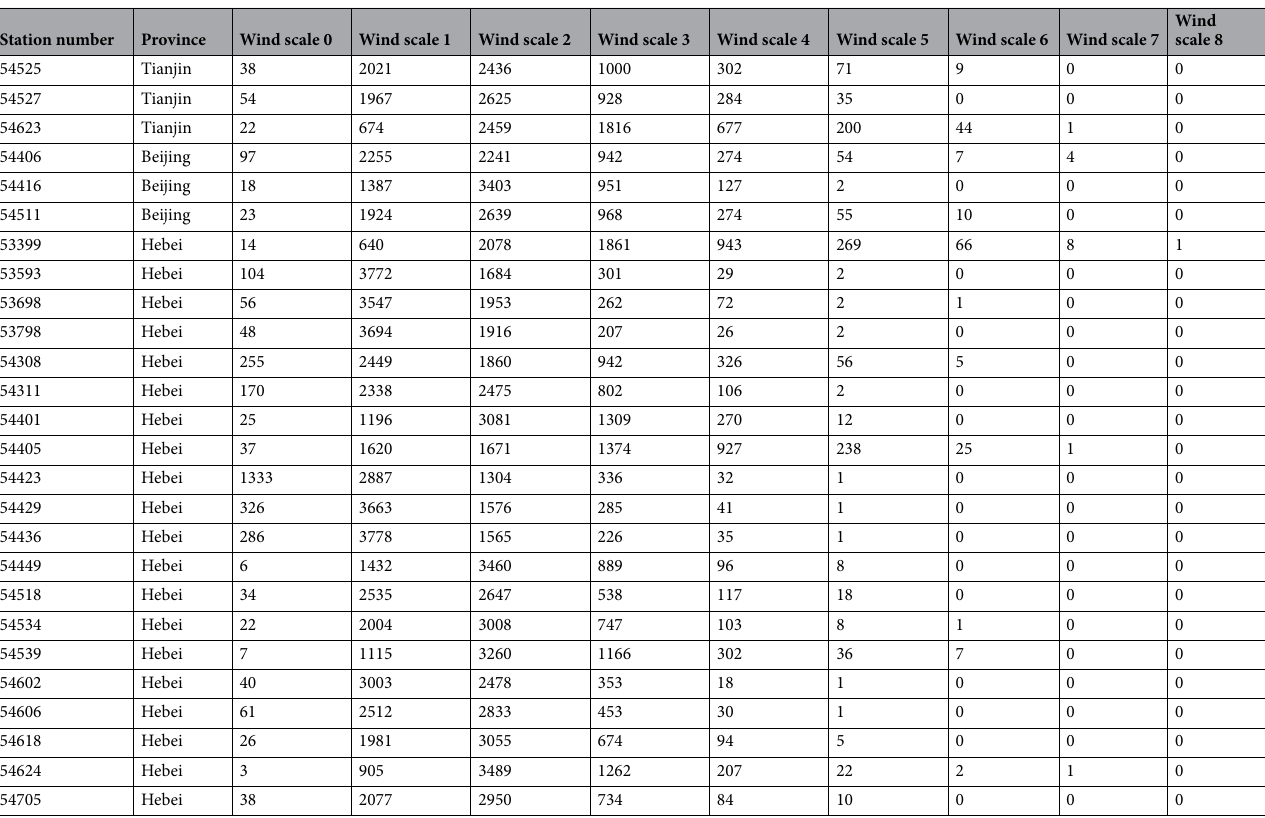
Table 2. Appearance frequency of different daily wind scales in the Beijing–Tianjin–Hebei region over the periods of 1, 2, 11, and 12 months from 1968 to